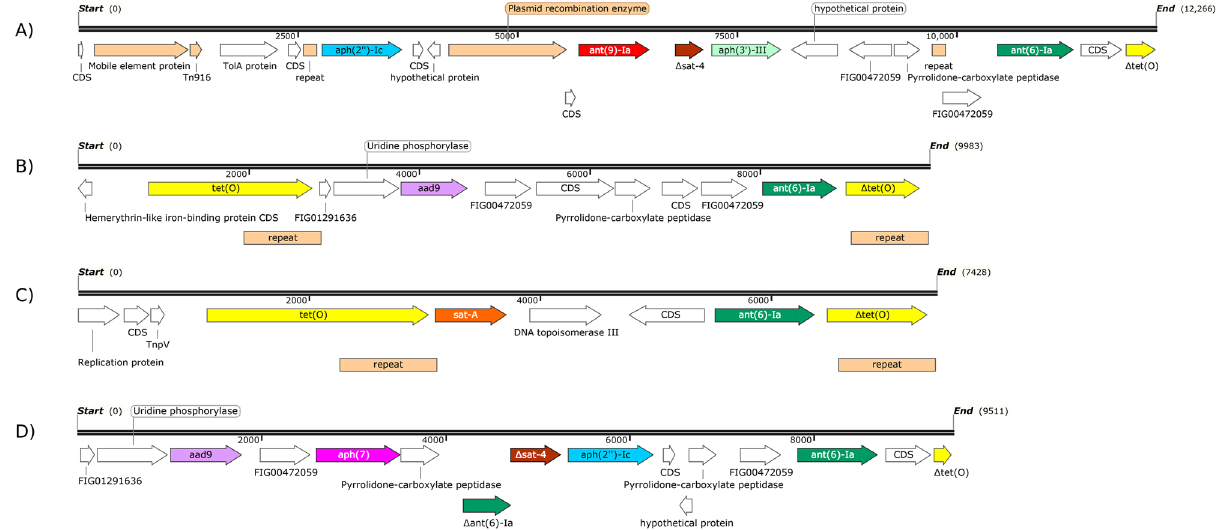
Figure 2. Aminoglycoside resistance clusters identified in nine C. coli and three C. jejuni isolates. Each coding sequence (CDS) is represented by an arrow with the direction indicating the translational direction. (cid:31) , truncated